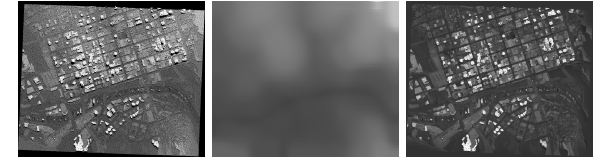
Figure 11. DSM, DTM and nDEM geographically correct pro- jected from the Pl´eiades Melbourne scene, 2500 m × 2000 m The spectral calibration derived in 2.4 works not very well for the Pl´eiades images. Of course Pl´eiades have only four multispectral bands in contrast to WorldView-2 so the criteria involving the yellow and the red-edge bands can no more be applied. Large shadow areas in the image lead to confusion of water and shadow classes. So special new parameters were derived from the images as shown in eqs. 7 through 9.